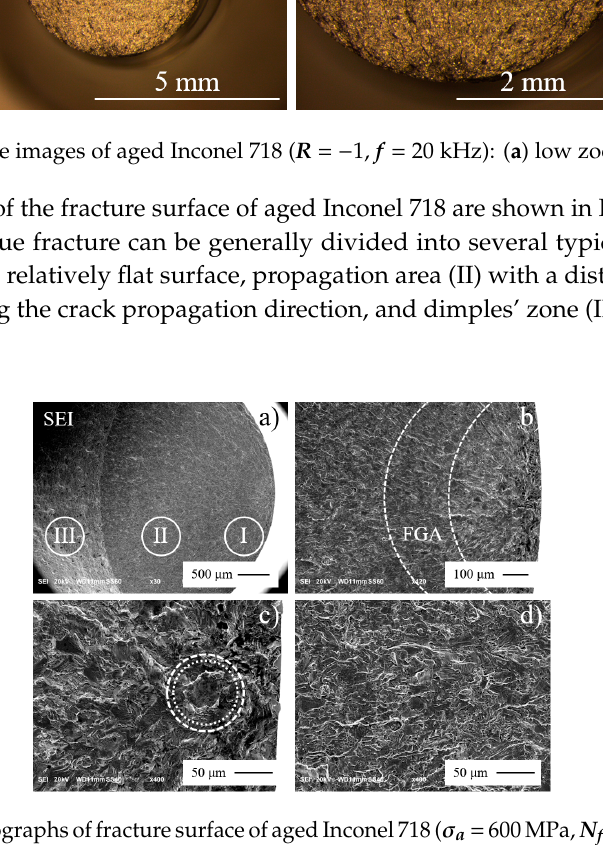
Figure 11. SEM micrographs of fracture surface of aged Inconel 718 ( σ a = 540 MPa, N f = 1.57 ∗ 10 9 cycles): ( a ) fatigue fracture, ( b ) initiation, ( c , d ) nucleation. Fine granular area (FGA) [43], also called optical dark area (ODA) [4] and granular bright facet (BGF) [44], indicates the boundary of initiation area I, as marked in Figure 10b. Secondary electrons were excited and emitted from the sample, then entered into the receiver probe inclined to the fracture surface. Thus, the steep surface and radial edge appeared brighter than flat surface FGA (Figure 10b). Murakami [4] assumed that FGA zones are caused by hydrogen embrittlement, in which hydrogen is trapped. Sakai [45] assumed that they are related to the polygonization of microstructure followed by debonding, resulting in crack initiation. Hong [46] proposed that a fine granular layer is observed only when the fatigue testing is conducted under negative load ratios, not under positive ratios. Crack was initiated at a subsurface smooth facet in the short life case (Figure 10c). The facet had a length of nearly 50 μ m and was located at 100 μ m from the specimen surface. According to the EDS analysis, the chemical composition of this facet was similar to the surrounding matrix. It was not a precipitation or inclusion. The formation of such facet has not been clearly explained up to now. Some authors [47,48] explained that such a fracture surface pattern comes from the sliding plane, while another author [21,37] proposed a twinning mechanism to explain the very smooth surface. It is